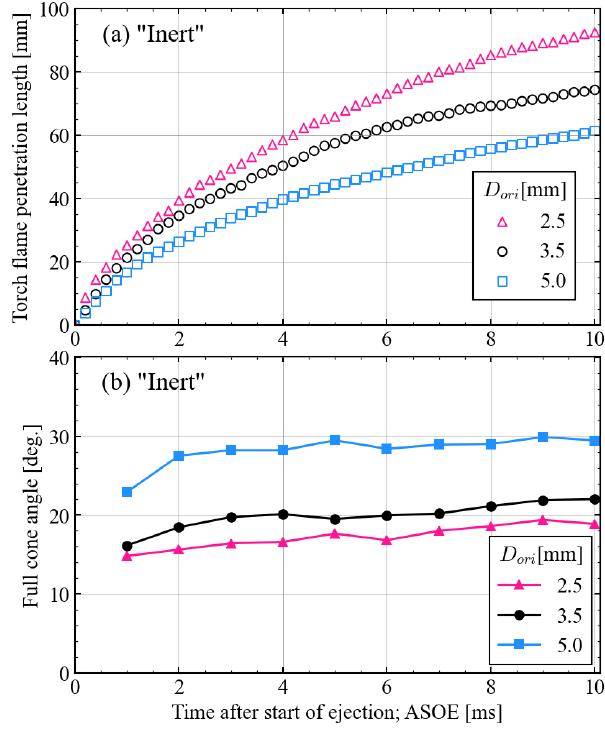
Fig. 14. Time history of (a) penetration, and (b) cone angle of different orifice diameter (D ori = 2.5, 3.5, 5.0 mm) under “inert” condition